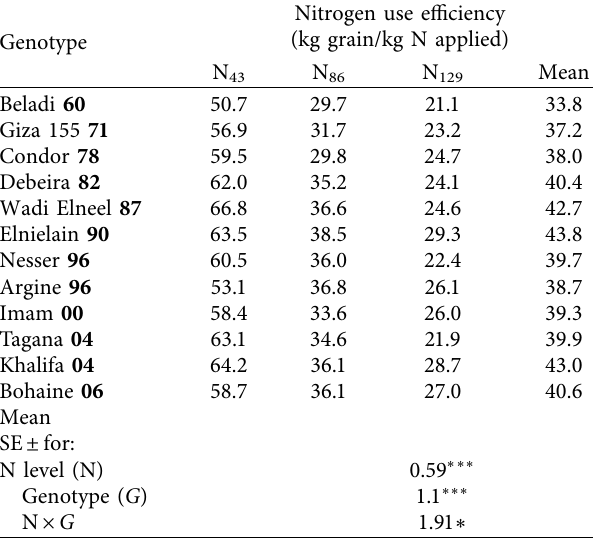
(Figure 4). At N production